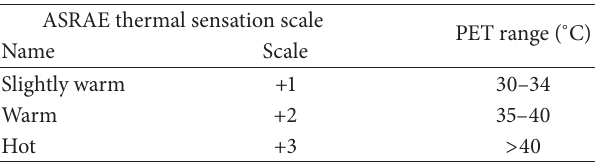
Table 2: Ranges of the physiologically equivalent temperature PET for different warm levels of human thermal sensation according to the ASHRAE thermal sensation scale determined for summer conditions in Freiburg [13].